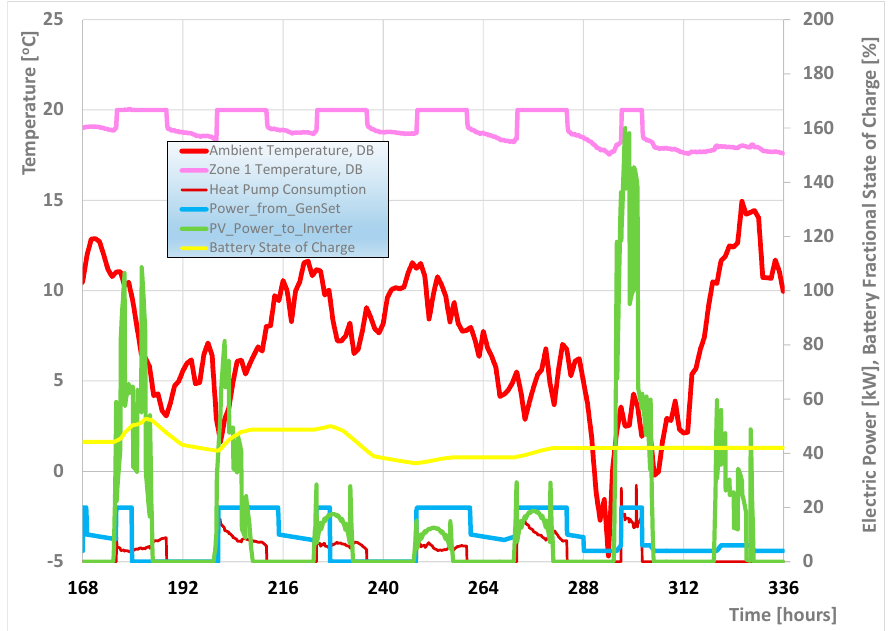
Figure 3. Transient operation of the system during the second week of January. Lowest threshold for aggregate batteries’ SOC = 0.36. 20 kW Genset. Indoor temperature set point 20 °C.